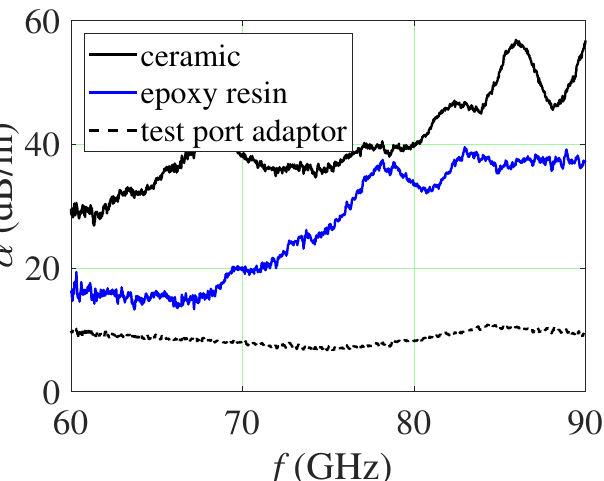
Figure 10. Measured attenuation coefficient α of the fabricated WR12 waveguides compared to a test port adaptor.